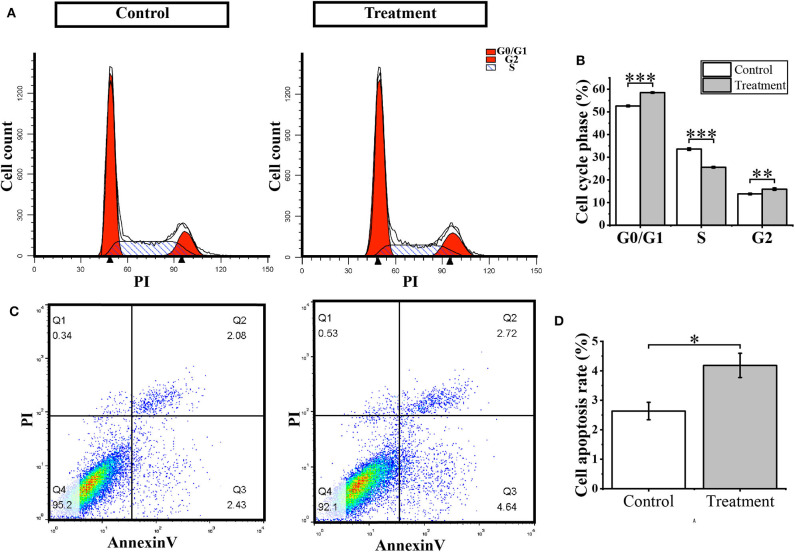
Cell cycle and apoptosis analysis. (A) Flow cytometry for cell cycle detection after treatment with 100 nmol/L (S)-2,3-Epoxysqualene U87 cells for 12 h. (B) Cell number distribution in each cell cycle. (C) Cell apoptosis detected by FACS analysis. (D) The ratio of apoptotic cells in U87 cells treated with 100 nmol/L (S)-2,3-Epoxysqualene for 12 h. Data represent means ± SD (n = 3). *P < 0.05, **P < 0.01, ***P < 0.001 by Student's t-test.